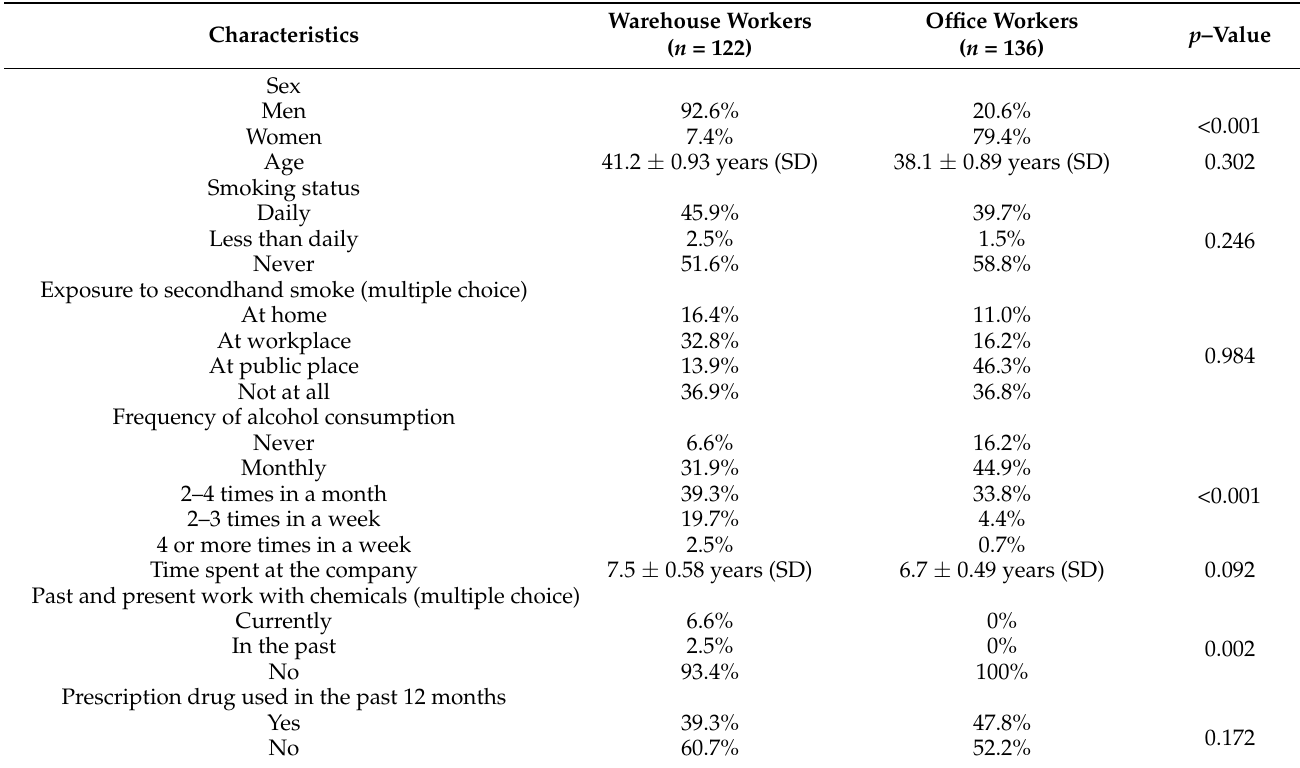
Table 1. Sociodemographic characteristics, lifestyle, and chemical exposure history of warehouse and office workers at Hungarian logistics companies.